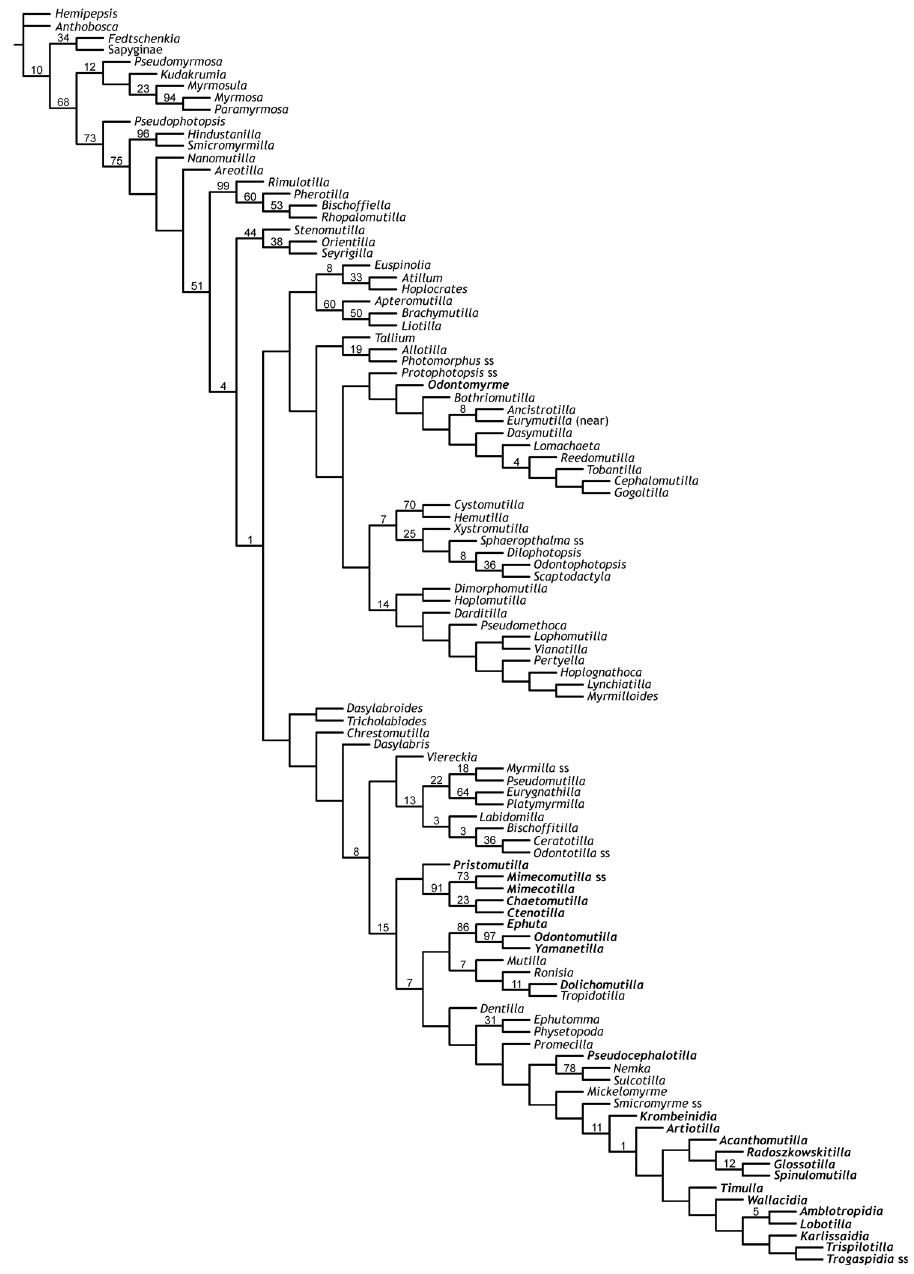
Figure 10. Single most-parsimonious tree (raw length = 1622, ci = 0.20, ri = 0.63), of 101 sub/genera of Mutillidae and 4 outgroups, males only, 140 characters many additive and all with implied weighting (N = 5, k = 71). Group support (GC) values shown for all groups supported by resampling. Terminals in bold are those whose placements differ by more than mere taxonomic level in the classifications of DB and LN (see Appendix